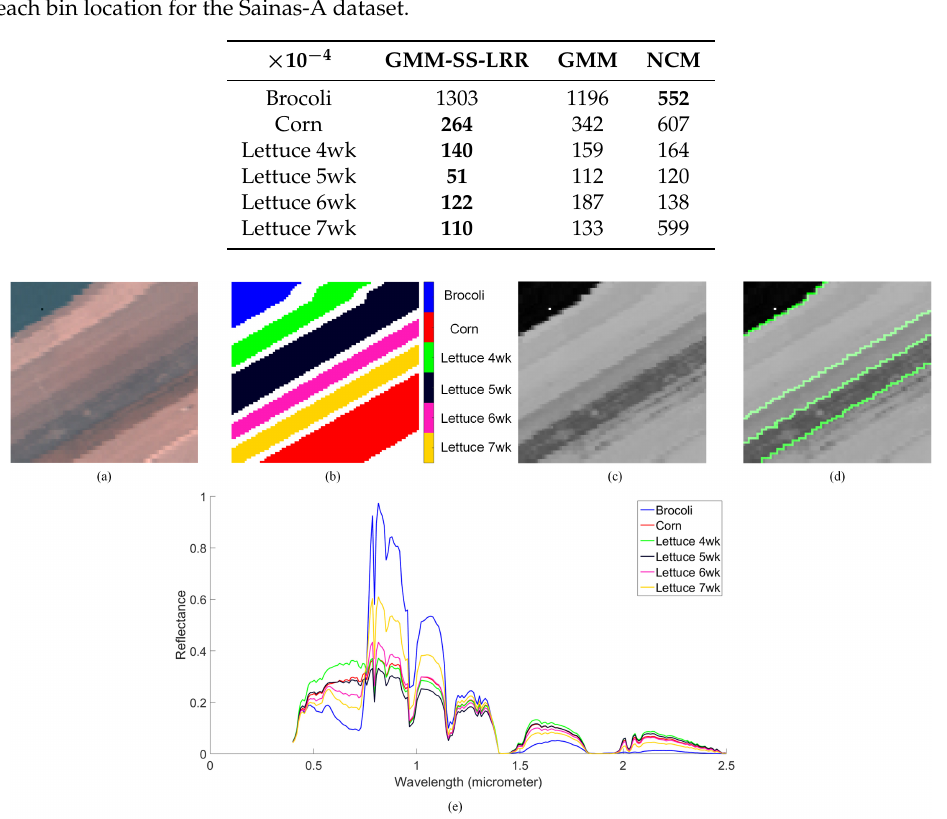
Figure 10. ( a ) Original RGB image of the Salinas-A dataset; ( b ) ground truth materials of broccoli, corn, lettuce 4wk, lettuce 5wk, lettuce 6wk and lettuce 7wk; ( c ) the first principle component of the Salinas-A dataset; ( d ) the superpixel map used for the Salinas-A dataset: and ( e ) the mean spectra of the six